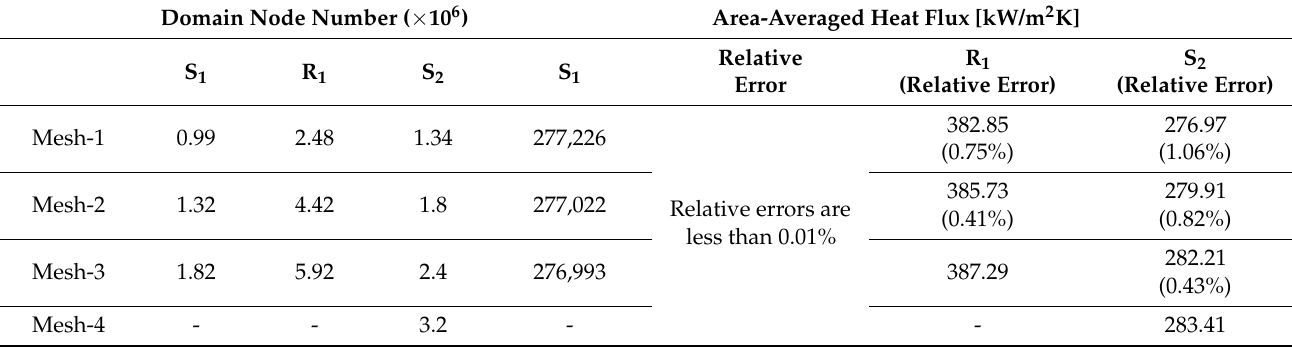
Table 1. Independent test mesh for the computational domain [5,14].